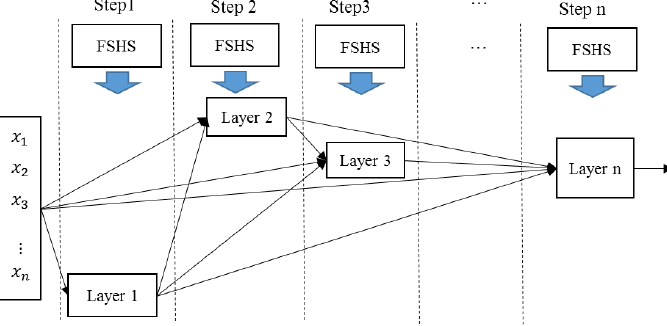
Figure 2. A schematic view of the FSHS-GMDH algorithm.